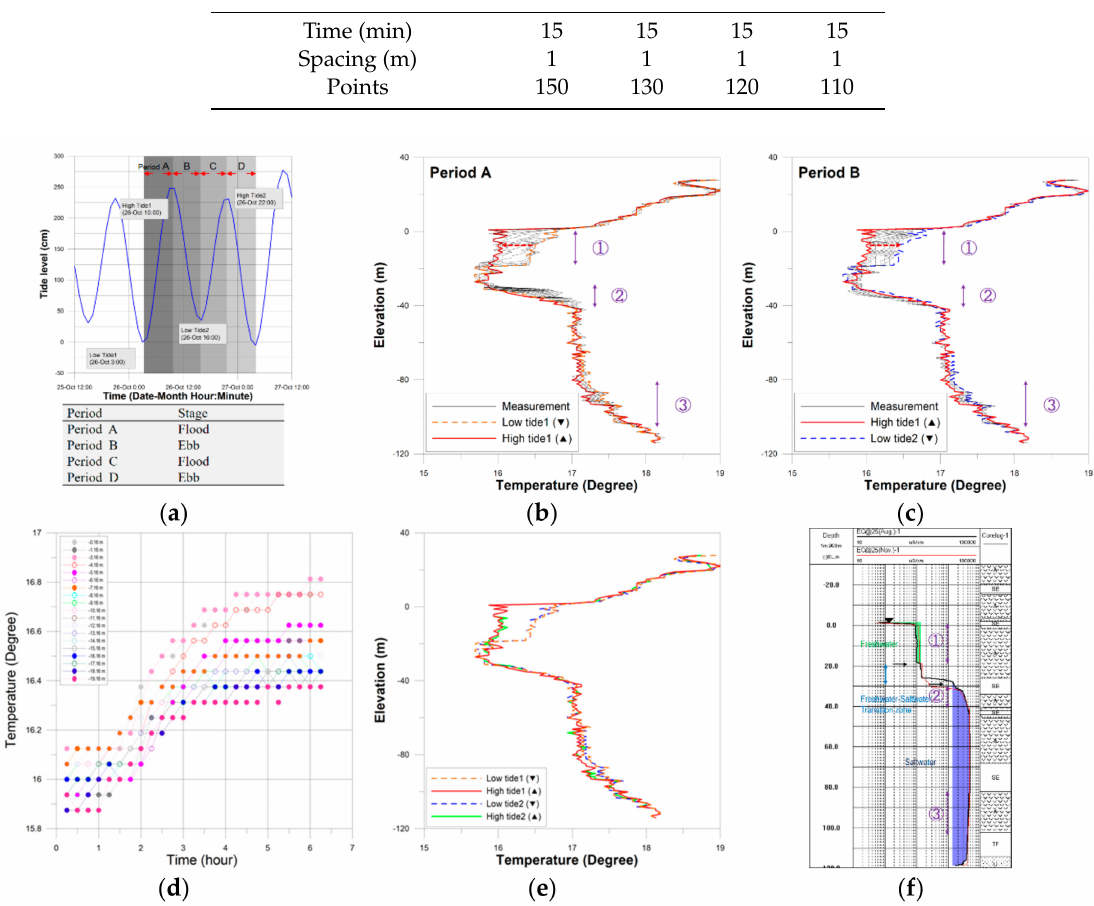
Figure 6. Temperature monitoring results with thermal line sensor in borehole SS-1. ( a ) Tide level; ( b ) temperature during Period A; ( c ) temperature during Period B; ( d ) temperature in Zone 1 during Period B; ( e ) temperature profiles at high and low tides; ( f ) electrical conductivity